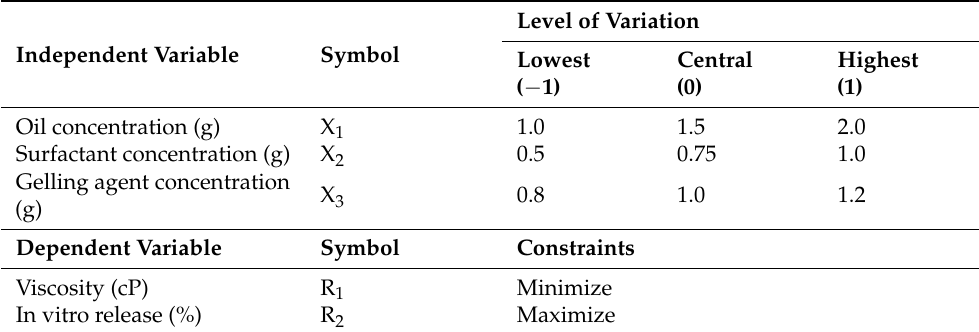
Table 6. BBD data displaying independent variables with their level of variation and the examined dependent